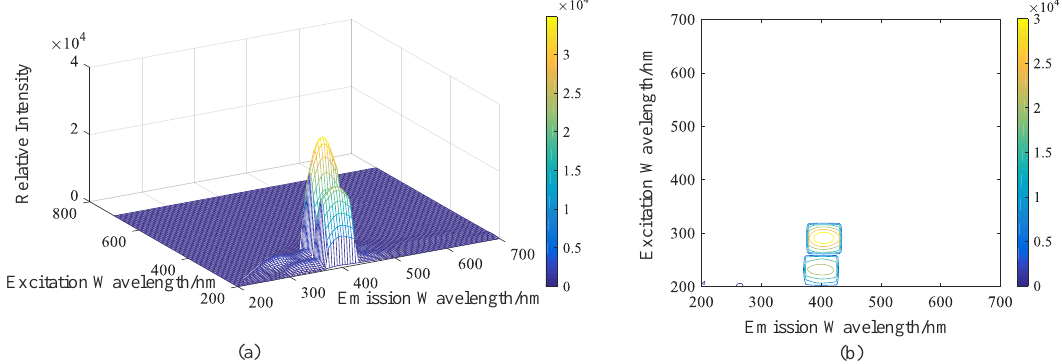
Figure 7. 3D ( a ) and contour ( b ) diagrams of 20 µ g / L salicylic acid positioning result.